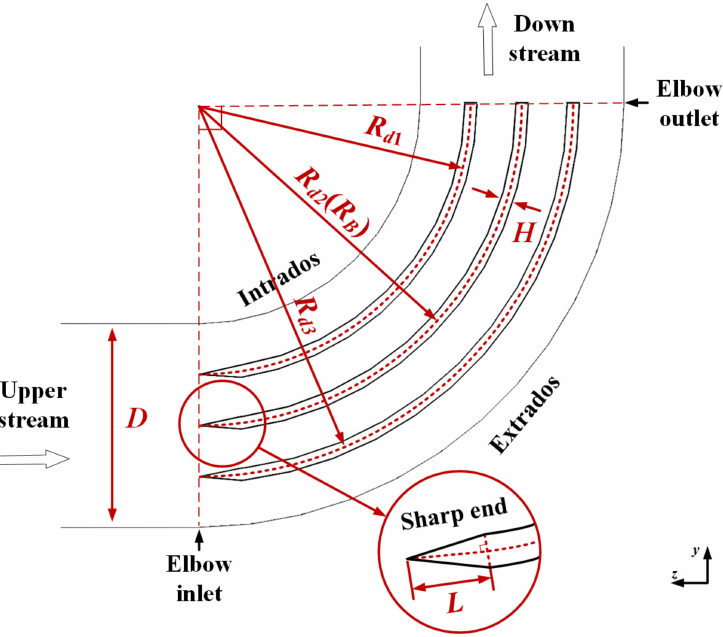
Figure 11. The schematic diagram of the optimization